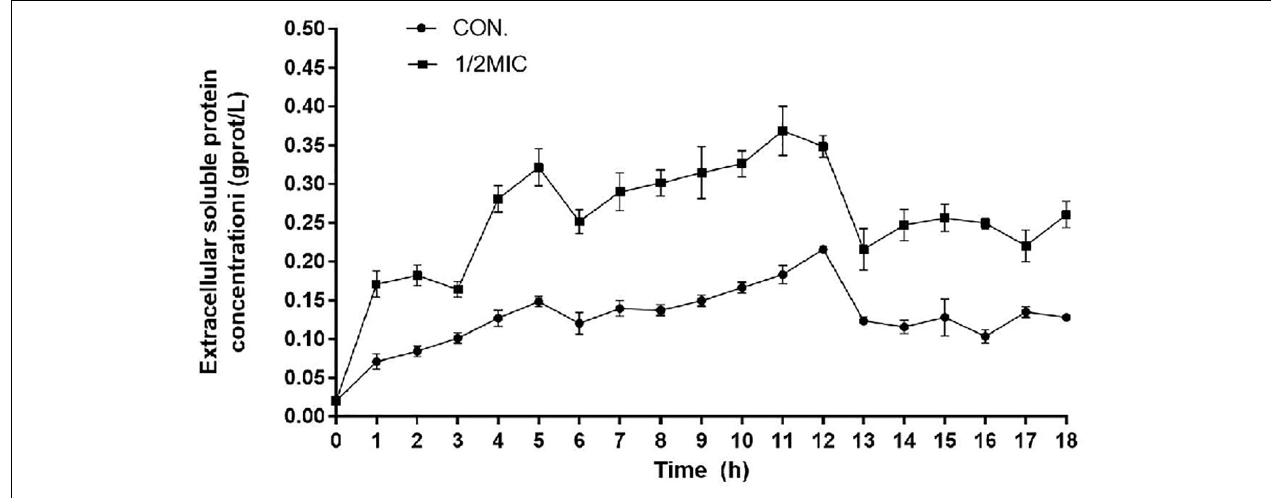
FIGURE 9 | Variation diagram of extracellular soluble protein concentrations.